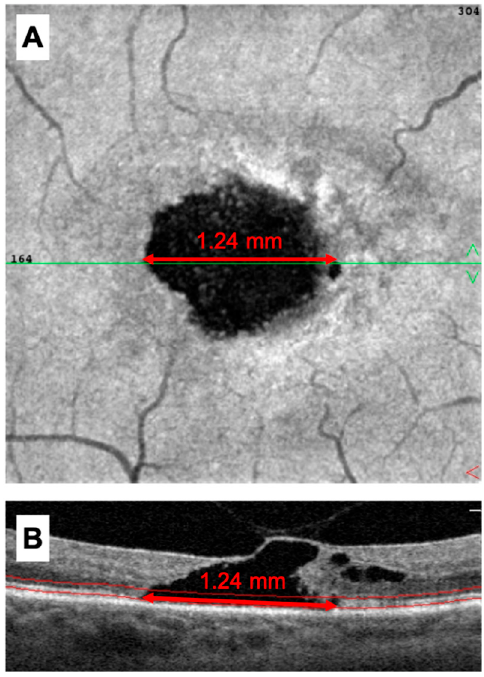
Figure 5. Measurement of ellipsoid zone (EZ) loss at the central fovea. ( A ) Dark or hyporeflective areas on en-face OCT represented EZ loss and was measured using the built-in caliper tool. Green line overlying en-face OCT represents the cross-sectional scan through the central fovea. ( B ) Length of EZ loss on cross-sectional OCT was cross-referenced to ensure consistency with en-face OCT. Manual segmentation of the EZ was performed as depicted by red borders on cross-sectional OCT.